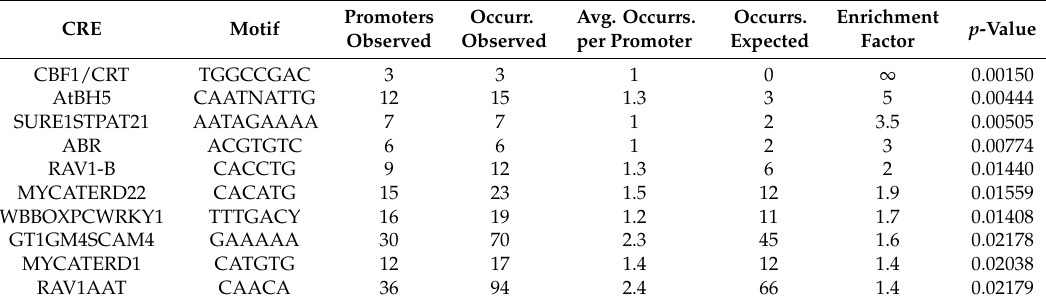
Table 3. Cis -regulatory elements (CRE) in asparagus NBS promoters (no. Of queries = 43). CRE Motif